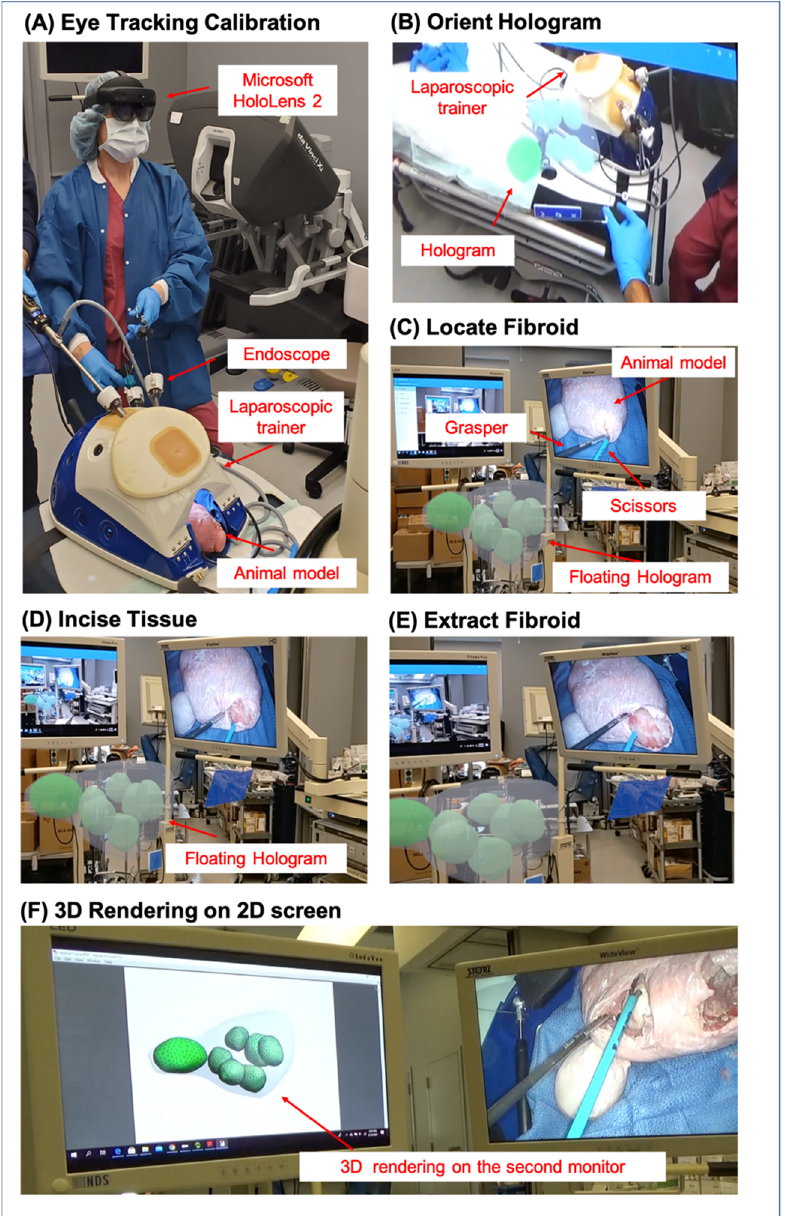
Figure 3. Illustration of sequential steps to perform a mock myomectomy of an ex vivo animal model using a mixed reality headset as an intra-procedural image-guidance tool. ( A ) Perform eye tracking user calibration to adjust the scene for a higher quality 3D visualization experience; ( B ) Orient the 3D hologram according to the live laparoscopic video; ( C ) Locate the position of the fibroids; ( D , E ) Incise tissue and perform myomectomy; ( F ) Display 3D rendering on 2D monitor.